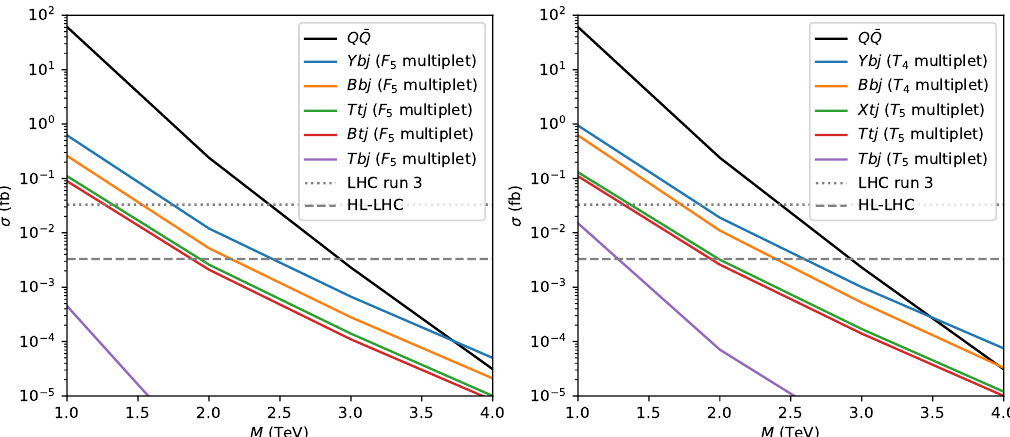
Figure 4 . Cross section for di(cid:11)erent processes for production of heavy quarks with y = (4 TeV) (cid:0) 1 and a center-of-mass energy of 14 TeV. The left plot corresponds to the F 5 quadruplet, while the right plot is for the T 5 and T 4 triplets. Pair production dominates for masses below ’ 3 : 5 TeV. The dotted and dashed gray lines represent the minimum cross section needed to obtain at least 10 events at the corresponding collider, assuming that the expected integrated luminosity is reached